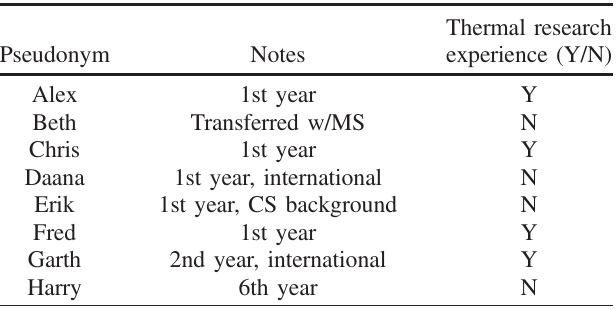
TABLE I. Student participant pseudonyms with brief summa- ries of their graduate-level standing and whether they self- reported any thermal physics (that is, either thermodynamics or statistical mechanics) related research experience. In the rows for Beth and Erik, MS and CS stand for Masters of Science and Computer Science,